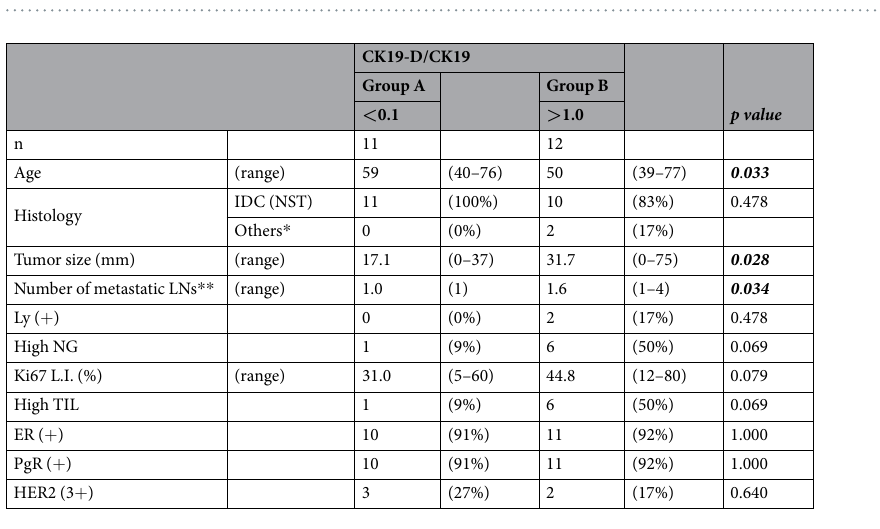
Figure 1. Inhibitory effects in the 72 patients. Orange bar indicates plus I cases, while dotted horizontal line indicates the median CK19-D/CK19 ratio, 0.41. Group A includes eleven cases showing no inhibitory effect, with a CK19-D/CK19 value of less than 0.1. Group B is comprised of 12 cases showing a strong inhibitory effect, as indicated by a CK19-D/CK19 value of 1.0 or more.